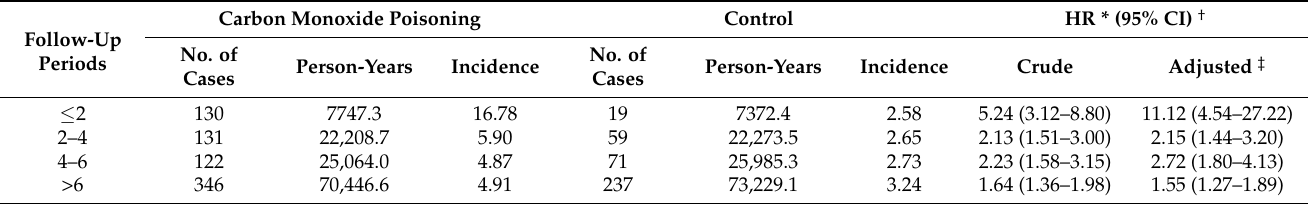
Table 4. Incidence and hazard ratios of ischemic heart disease as stratified by follow-up